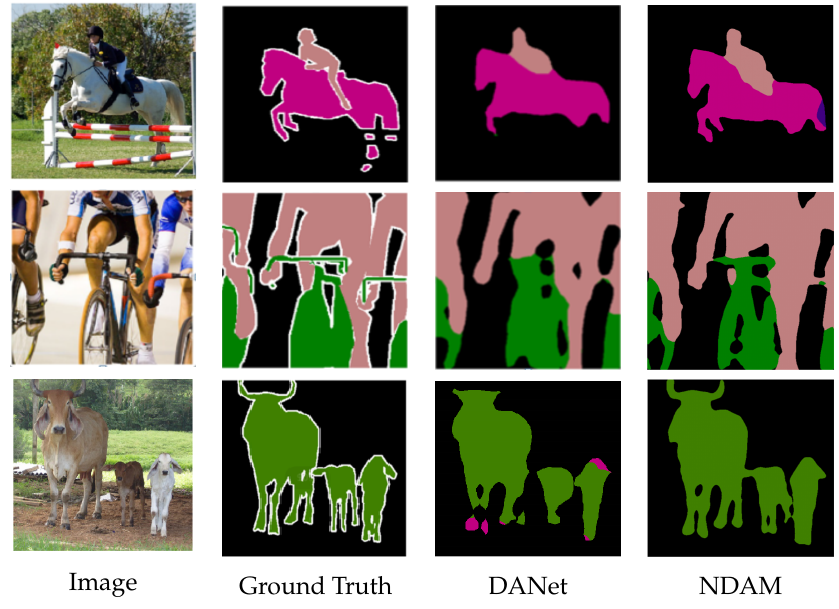
Figure 6. Visual comparison chart of NDAM and DANet. Table 1. Ablation experiment on PASCAL VOC 2012 dataset, H , W = 33 means taking the entire row and the entire column in turn when taking adjacent pixels for similarity calculation. H , W = (cid:52) means that the number of adjacent pixels varies with the position of the pixel when the adjacent pixels are used for similarity calculation, with more in the middle and fewer on the